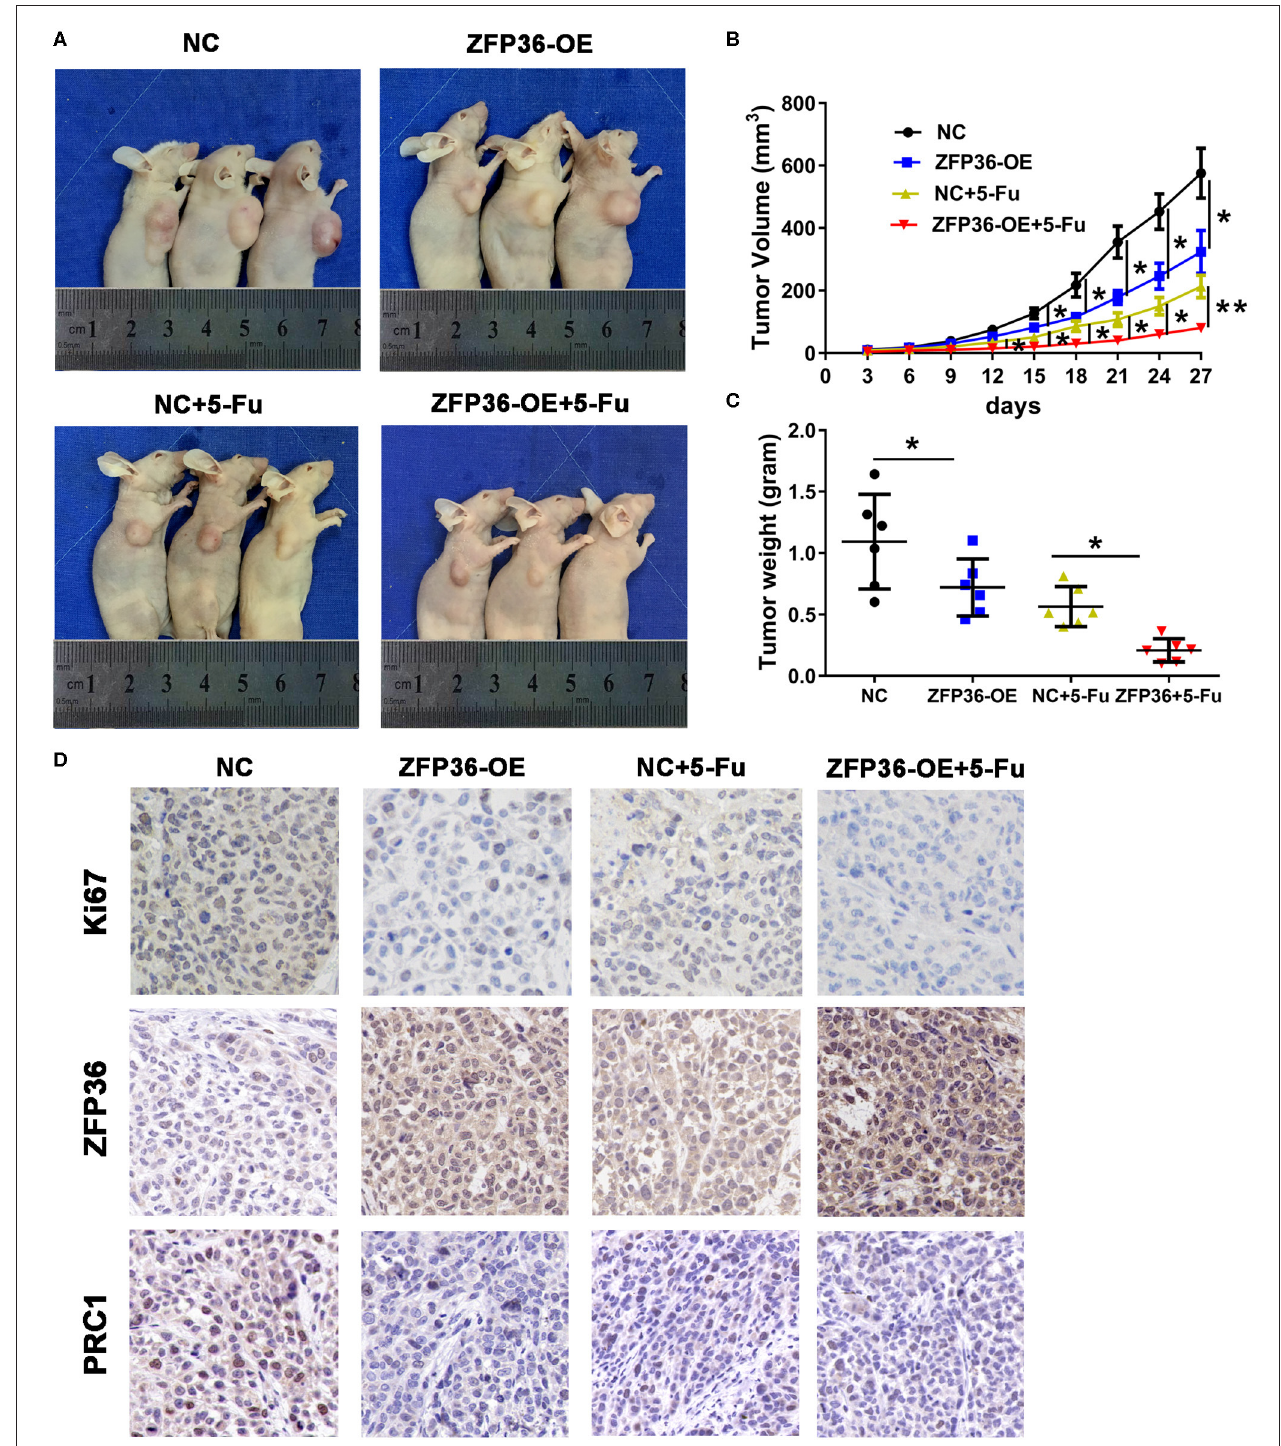
FIGURE 5 | ZFP36 increases the curative effect of 5-Fu on tumor growth in nude mice. (A) The tumor growth curve of ZFP36 overexpressed in Huh7 cells was compared with vector-expressing cells with or without 5-Fu treatment. HepG2 cells (2 × 10 6 ) were infected with negative control (NC) or ZFP36-OE. Infected cells were subcutaneously injected into the flanks of 6-week-old male nude mice to induce tumor. Mice were sacrificed 27 days after injection. Photos were captured, and tumor growth was assessed. (B,C) Average tumor weight was measured and growth curves were generated. (D) Ki67, ZFP36, and PRC1 expression were analyzed by immunohistochemistry (IHC). * p < 0.05, ** p < 0.01.